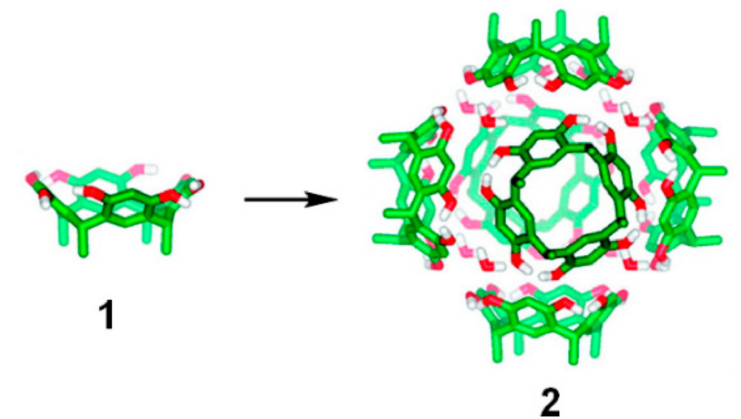
Figure 1. Resorcin[4]arene 1 and resulting hexameric capsule 2 (Adapted with permission from J. Am. Chem. Soc. 2008, 130, 2344. Copyright 2008 American Chemical